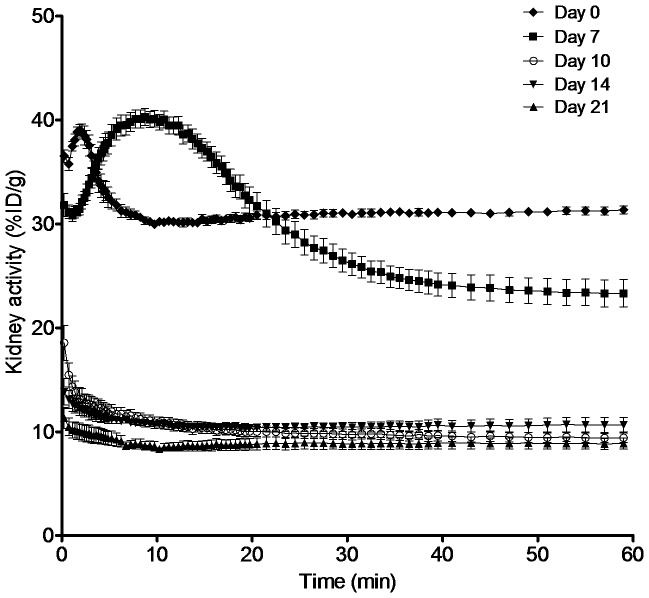
Quantitative analysis of PET-CT images.Time-activity curves of FDG in kidneys (left and right kidneys pooled) reconstructed at short time intervals (0–1 min: 30 s; 1–5 min: 15 s; 5–20 min: 30 s; 20–40 min: 60 s; 40–60 min: 120 s). Day 0, 7, 14, and 21: n = 4–5. Error bars are the standard deviation. The defined nephritis characteristic phase is visualized in 0–30 min.